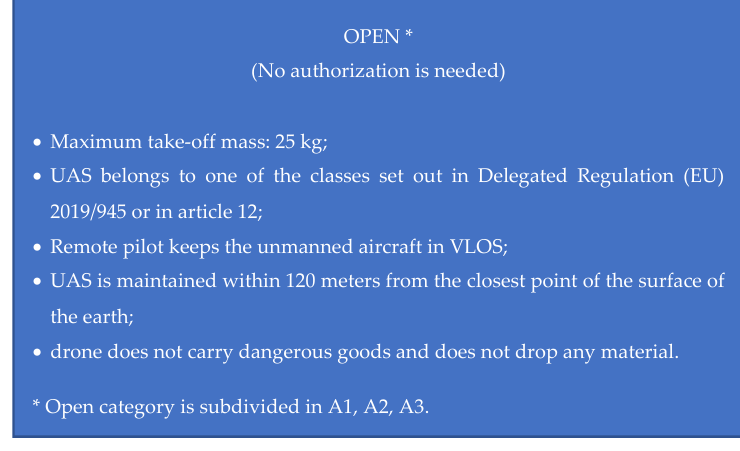
Figure 4. Constraints for the open category.